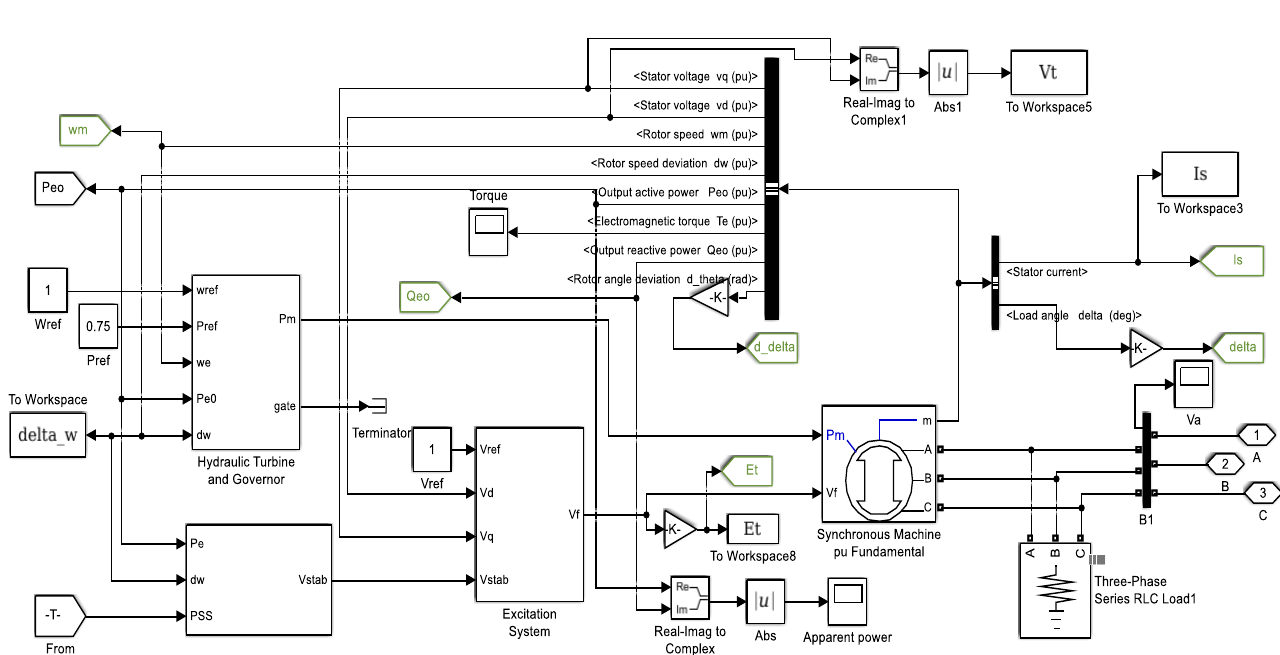
Table 5. Comparison of simulation results of different algorithms.